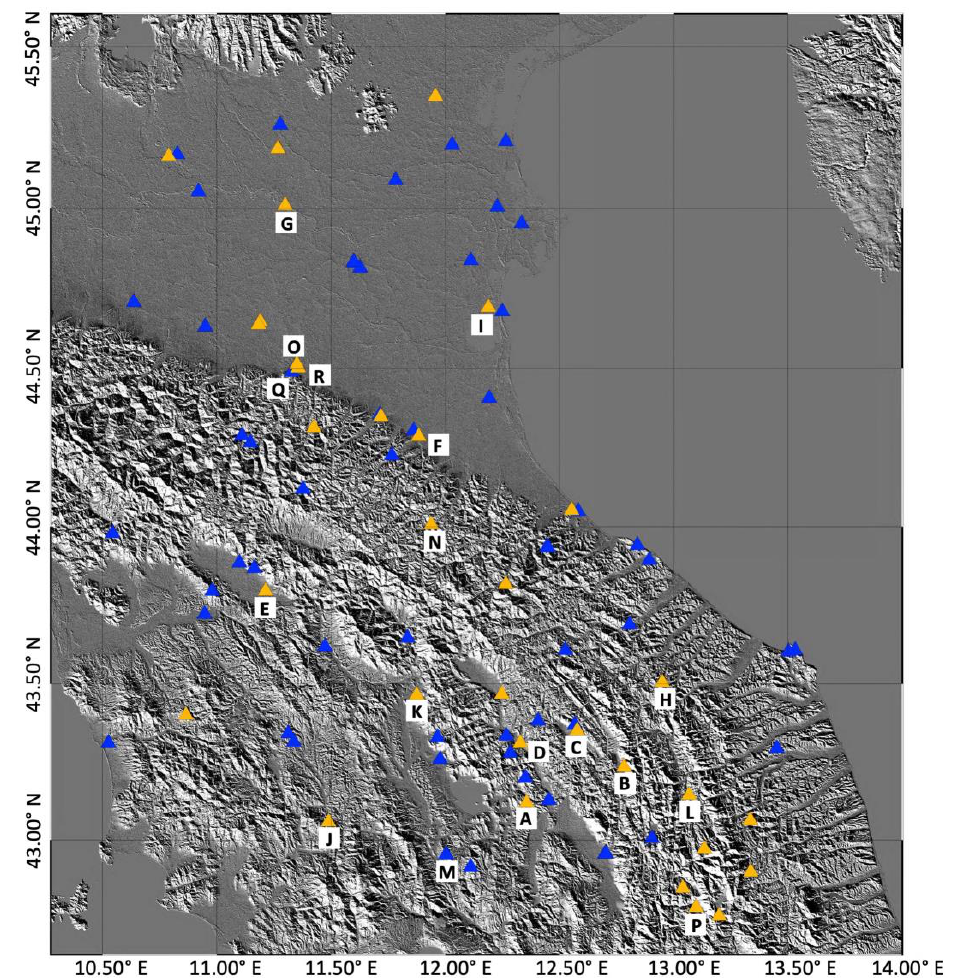
Figure 7. SRTM DEM map of the investigated portion of the Central-Northern Italy, shown in Figure 6, highlighting the locations of the GNSS stations. Blue and yellow markers represent stations exploited for and excluded from the DInSAR deformation signals refinement step, respectively.